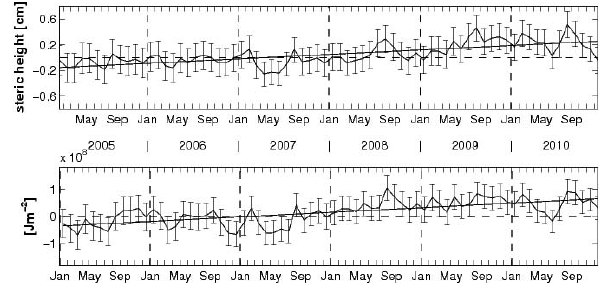
Fig. 7. Global ocean heat content and mean steric sea level varia- tions derived from Argo data (2005–2010) (from von Schuckmann and Le Traon,